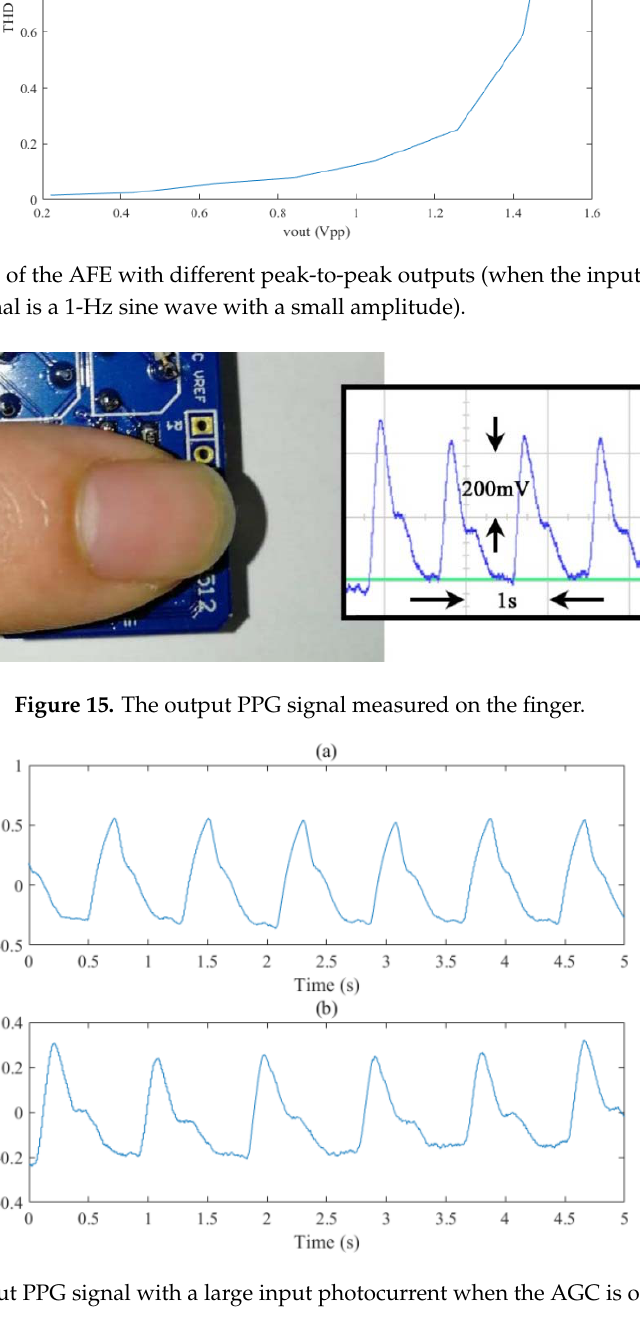
Figure 14 . The THD of the AFE with different peak ‐ to ‐ peak outputs (when the input photocurrent is 1.12 μ A and the signal is a 1 ‐ Hz sine wave with a small amplitude).